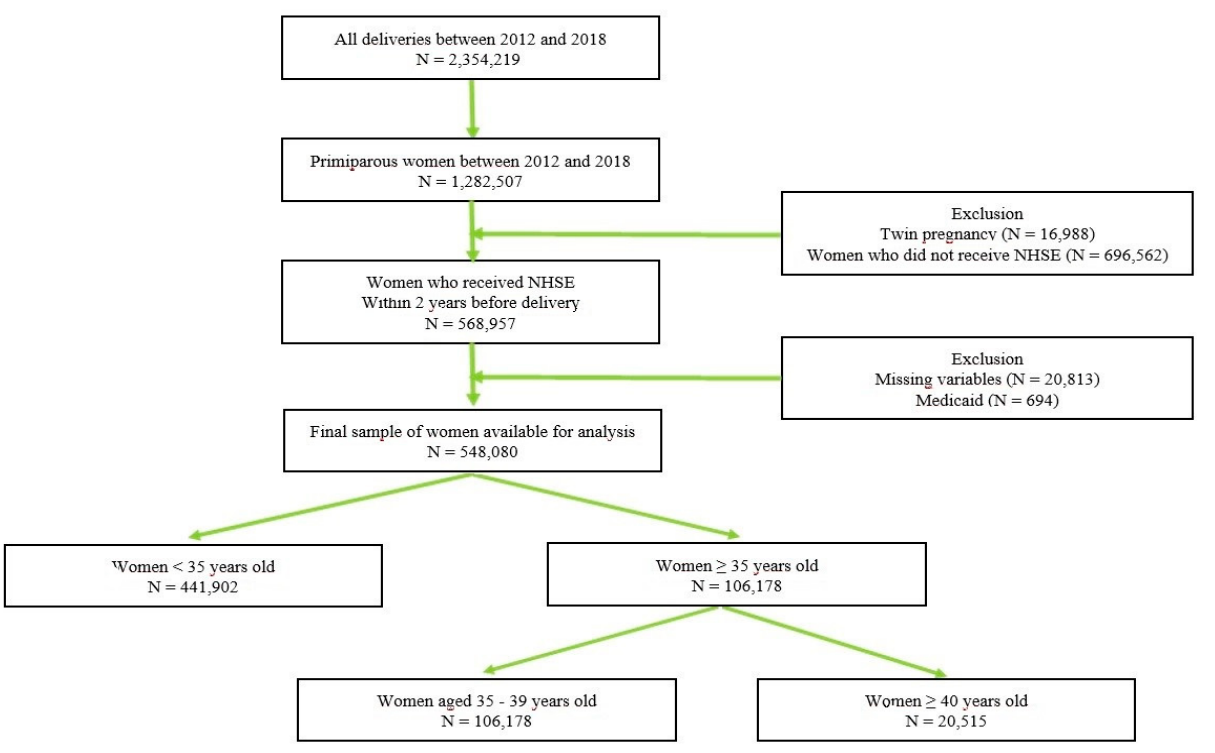
Figure 1. Study Flow